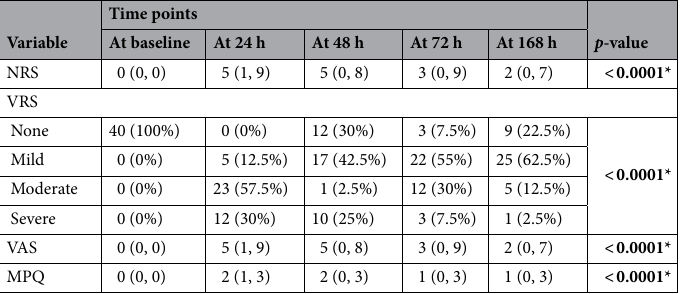
Table 1. Comparison of subjective pain score namely VAS, VRS, NRS and MPQ over time points. Significant values are in [bold]. * p < 0.05.